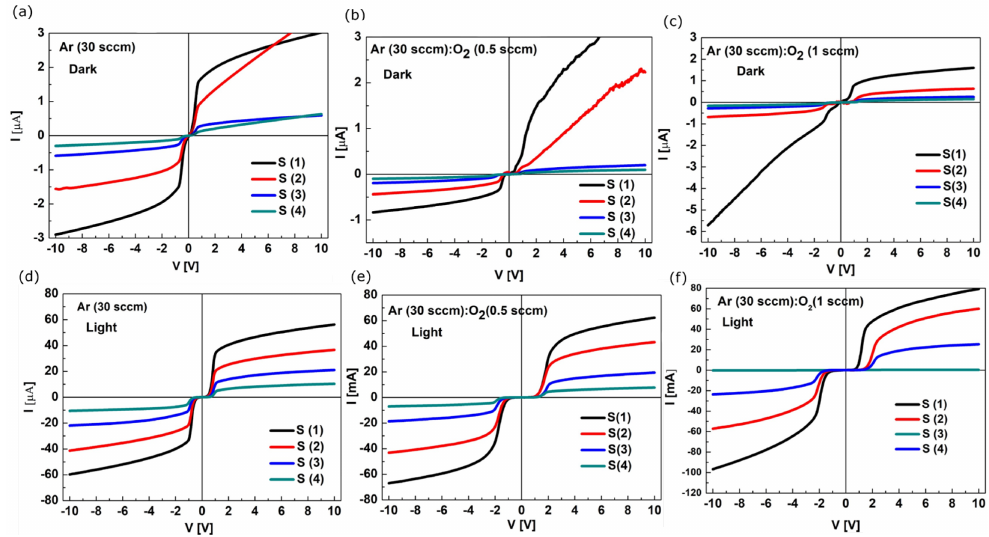
Figure 4. The I − V characteristics of the V x O y films with various oxygen content. The contact area is a parameter. Measurements performed in conditions of dark ( a − c ) and under white light illumination ( d − f